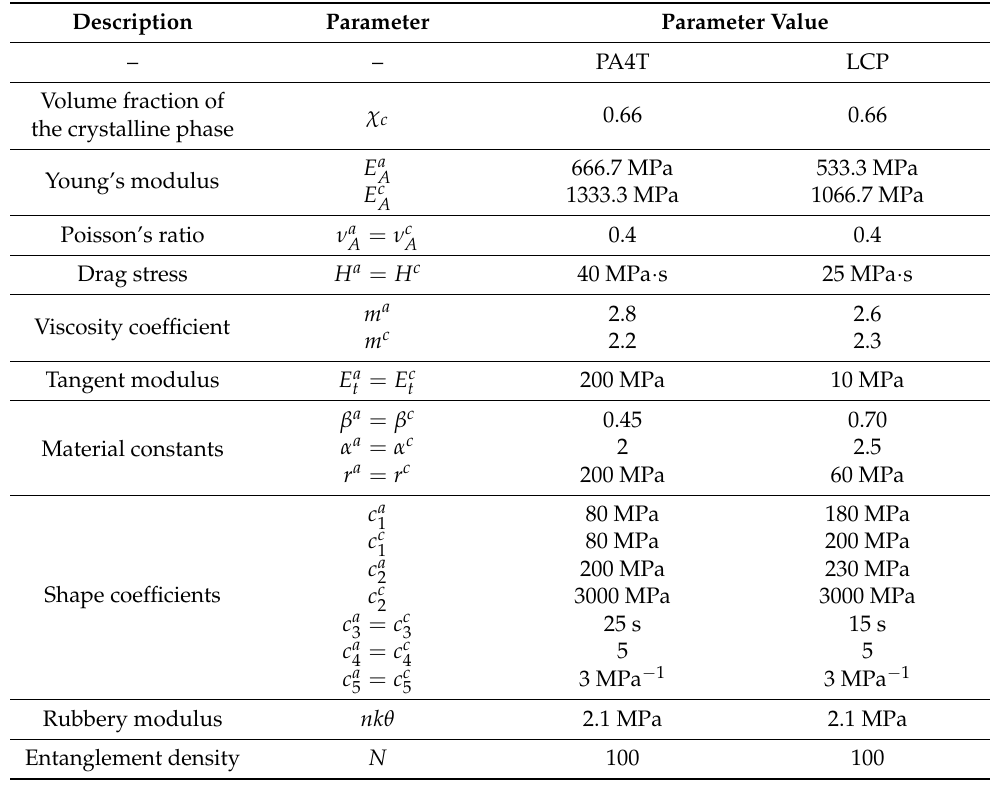
Table 1. Parameters adopted for the modified VBO model.